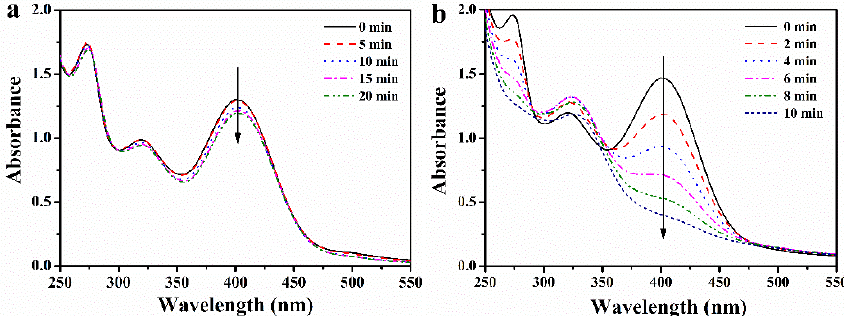
Figure 7. The UV–Vis spectra of the oxidation of morin ( a ) without the catalyst every 5 min and ( b ) with the PO-PdNPs 75 every 2 min. Table 1. Comparison of K nor and TOF of PO-PdNPs n with other Pd-based catalysts in 4-NP reduction.